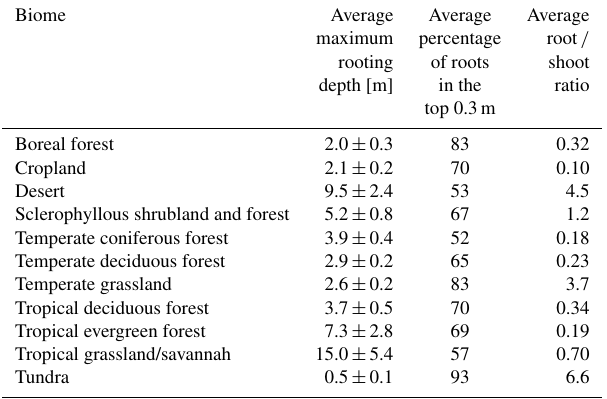
Table 2. Average maximum rooting depth, biomass–depth distri- bution, and root / shoot ratios in different biomes (Canadell et al., 1996; Jackson et al., 1996).